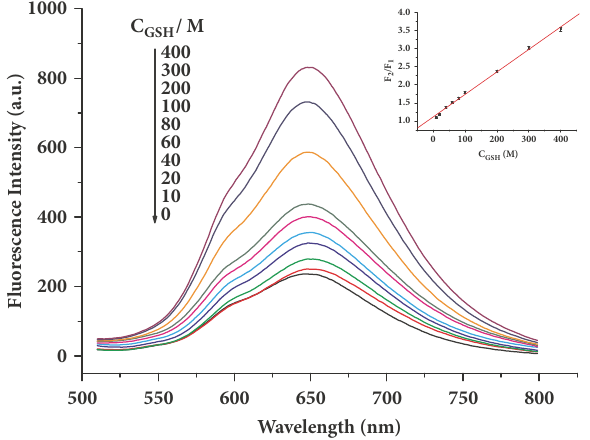
Figure 6: Fluorescence recovery from the quenched AuNCs-BSA by adding of various concentrations of GSH. Inset: relationship between the fluorescence recovering efficiency and the concentra- tion of